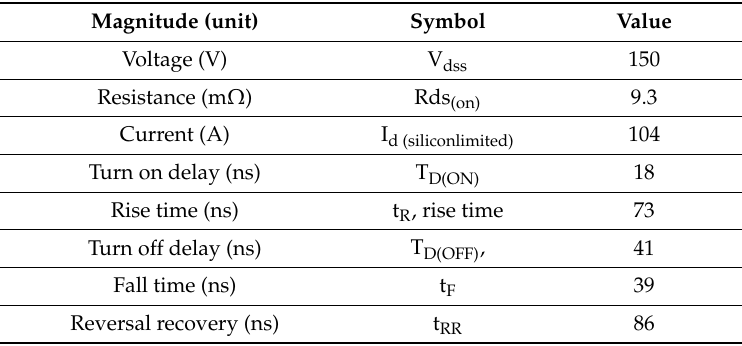
Table 1. Features of the IRFB4115PBF device [43].